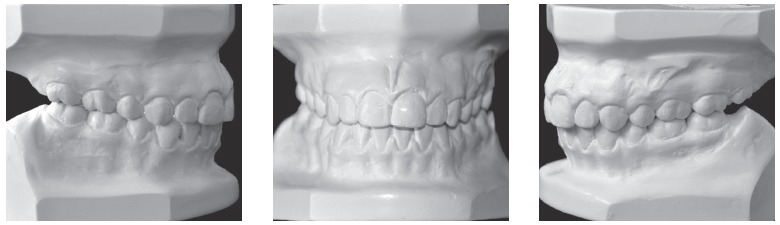
Final dental casts.